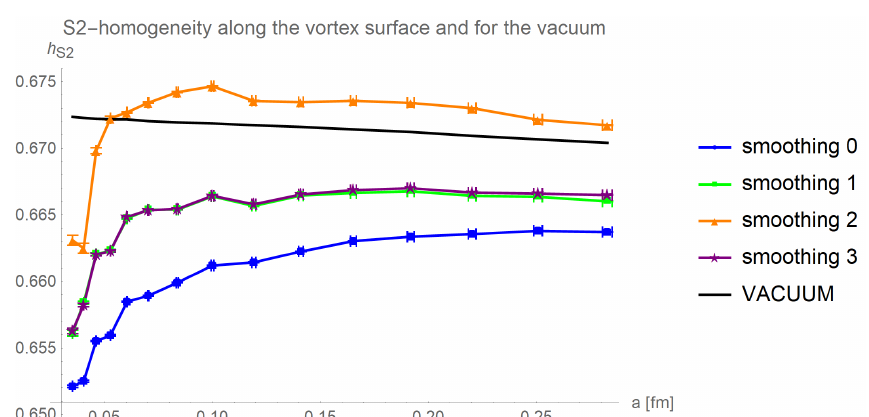
Figure 7. Averaged over 100 configurations of size 12 4 , the S2-homogeneity along the vortex surface is shown for different smoothing procedures. The vacuum value (black line), that is, the value throughout the whole lattice, is shown for